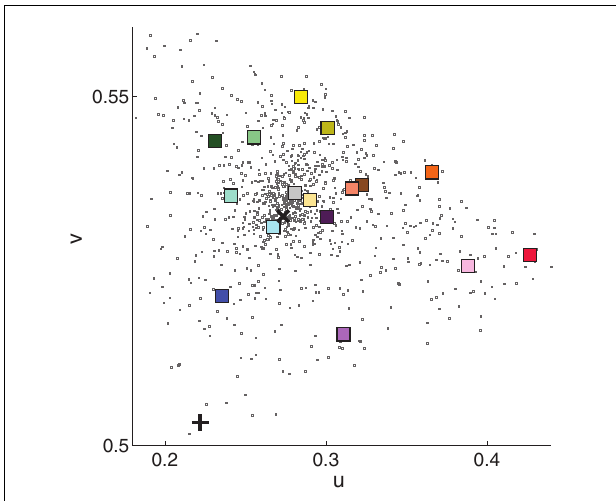
FIGURE 1 | Chromaticity in CIE uv coordinates of the 16 cube stimuli (colored squares), 1022 paint chips (black dots), and illumination for Booth A (black x) and Booth B (black + ). Luminance information was discarded. Plotted measurements were made in Booth A. The square’s color is an approximation of the cube’s apparent color.